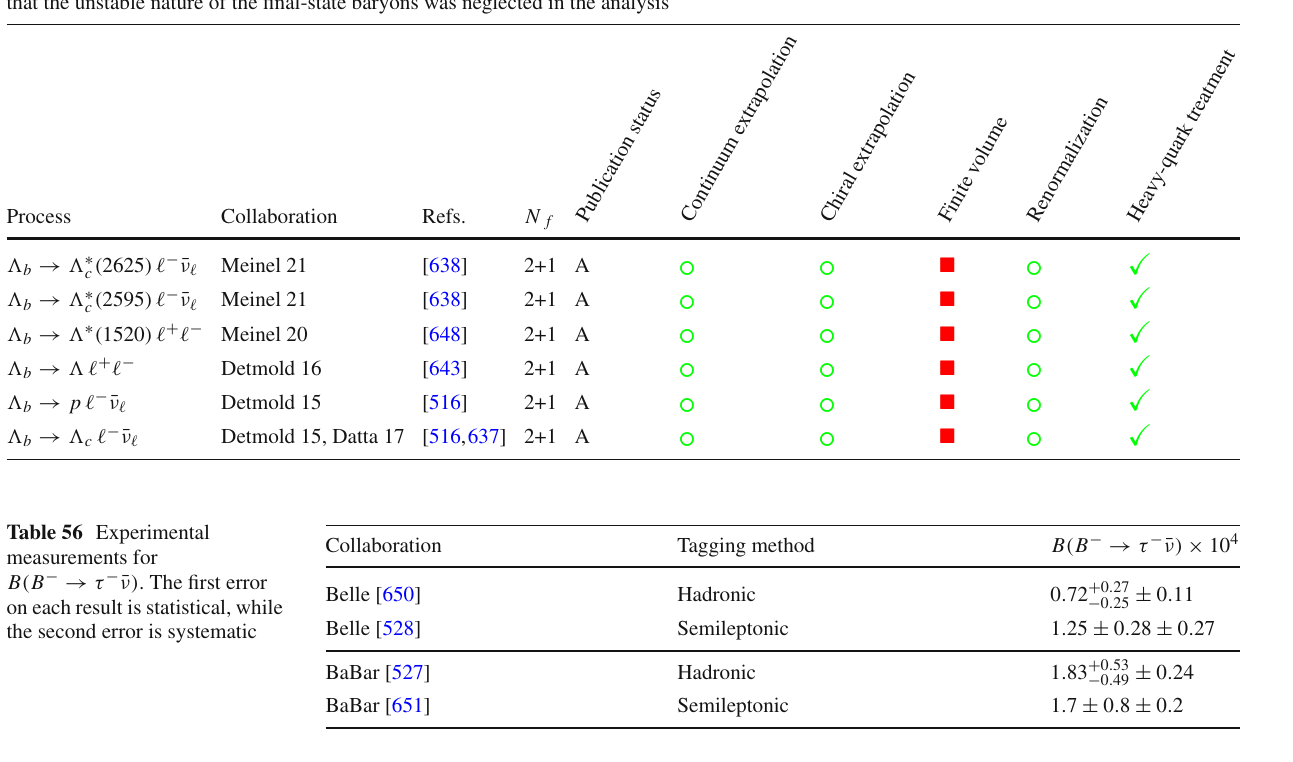
Table 55 Summary of computations of bottom baryon semileptonic form factors (see also Refs. [642,649] for calculations with static b quarks). The rationale for the (cid:4) rating of finite-volume effects in Meinel 20 and 21 (despite meeting the ◦ criterion based on the minimum pion mass) is that the unstable nature of the final-state baryons was neglected in the analysis